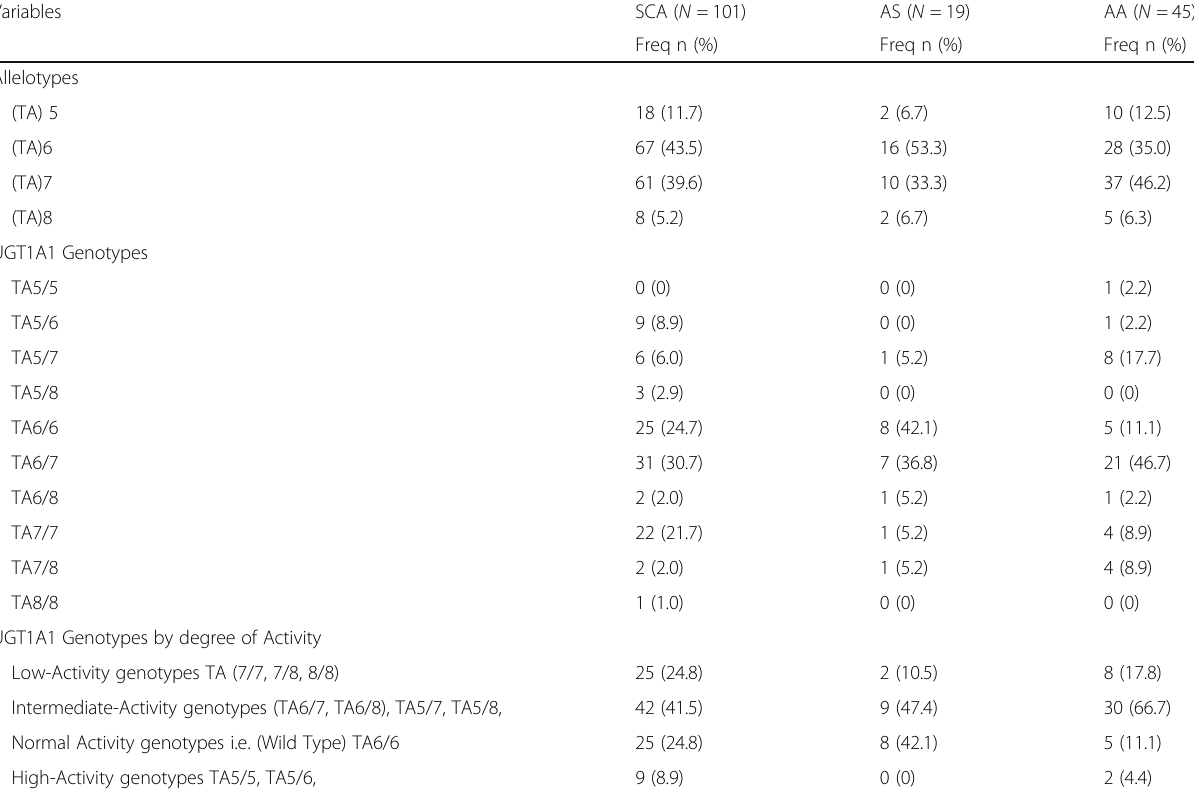
Table 1 Allele and genotype frequencies of UGT1A1 promoter polymorphisms among participants